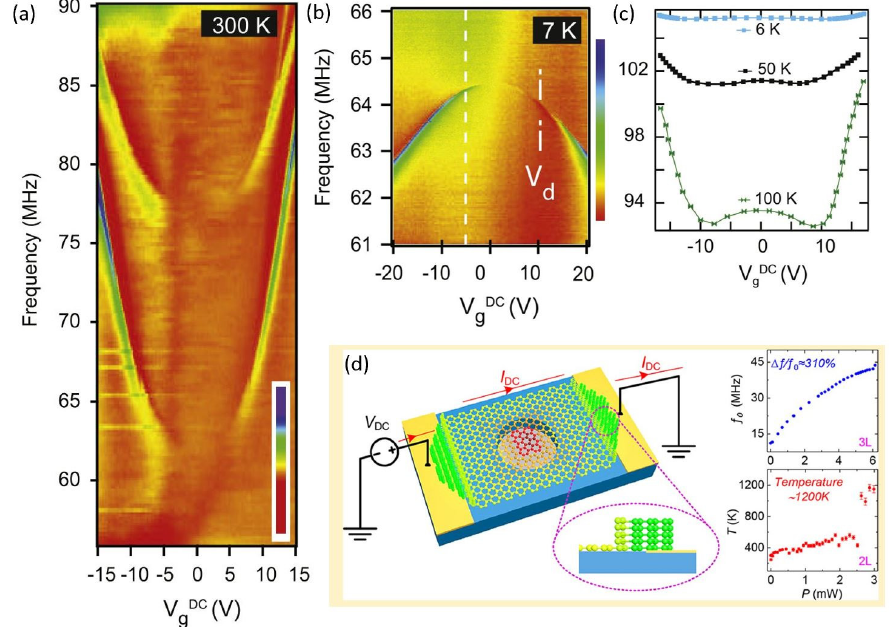
Figure 5. Frequency tuning of graphene resonator. ( a ) Spring hardening effect [29]. ( b ) Spring sof- tening effect [29]. ( c ) The competition between the two effects with ‘W’ tuning behavior [29]. ( d ) Frequency tuning by Joule heating [56].